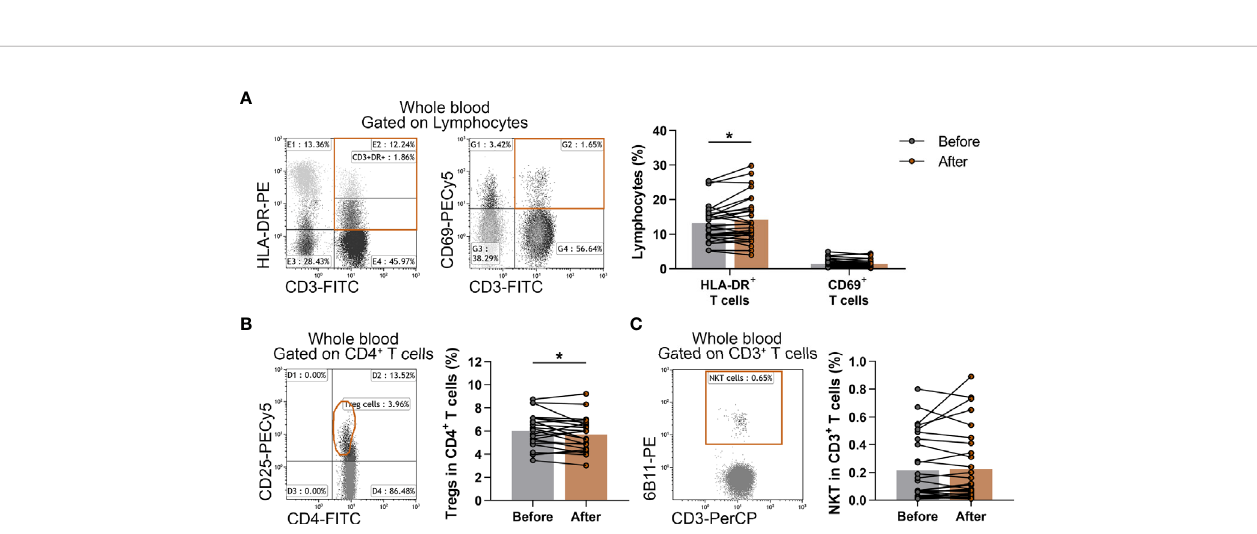
FIGURE 4 | Assessment of the changes of activated T cells, Treg cells and NKT cells in elderly women after exercise program. Whole blood of 29 elderly women were stained with labeled monoclonal antibodies as described previously. Activated T cells were quanti fi ed as their percentages in the lymphocyte population, Treg cells were assessed as their frequencies in the CD4 + cells and NKT cells were quanti fi ed as their percentages in CD3 + cells. (A) Representative dot plots demonstrate the identi fi cation of CD3 + HLA-DR + late activated and CD3 + CD69 + early-activated T cells. The bar chart indicates the frequencies of activated T cells. (B) Representative dot plot indicate the identi fi cation of CD4 + CD25 bright Treg cells. The CD25 bright population was identi fi ed accurately after gating to CD127 lo/- T cells (not represented). The bar chart indicates the ratio of Treg cells. (C) Representative dot plot shows the determination and the bar chart indicates the frequencies of CD3 + 6B11 + NKT cells. Paired T test was used. Each data point represents an individual subject, while bars show the mean values. Statistically signi fi cant differences are indicated by *p <